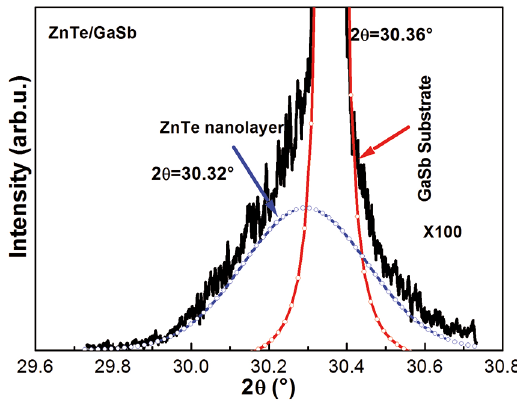
Figure 4: ZnTe and GaSb deconvoluted (004) peak. The substrate and layer peaks are difficult to resolve.